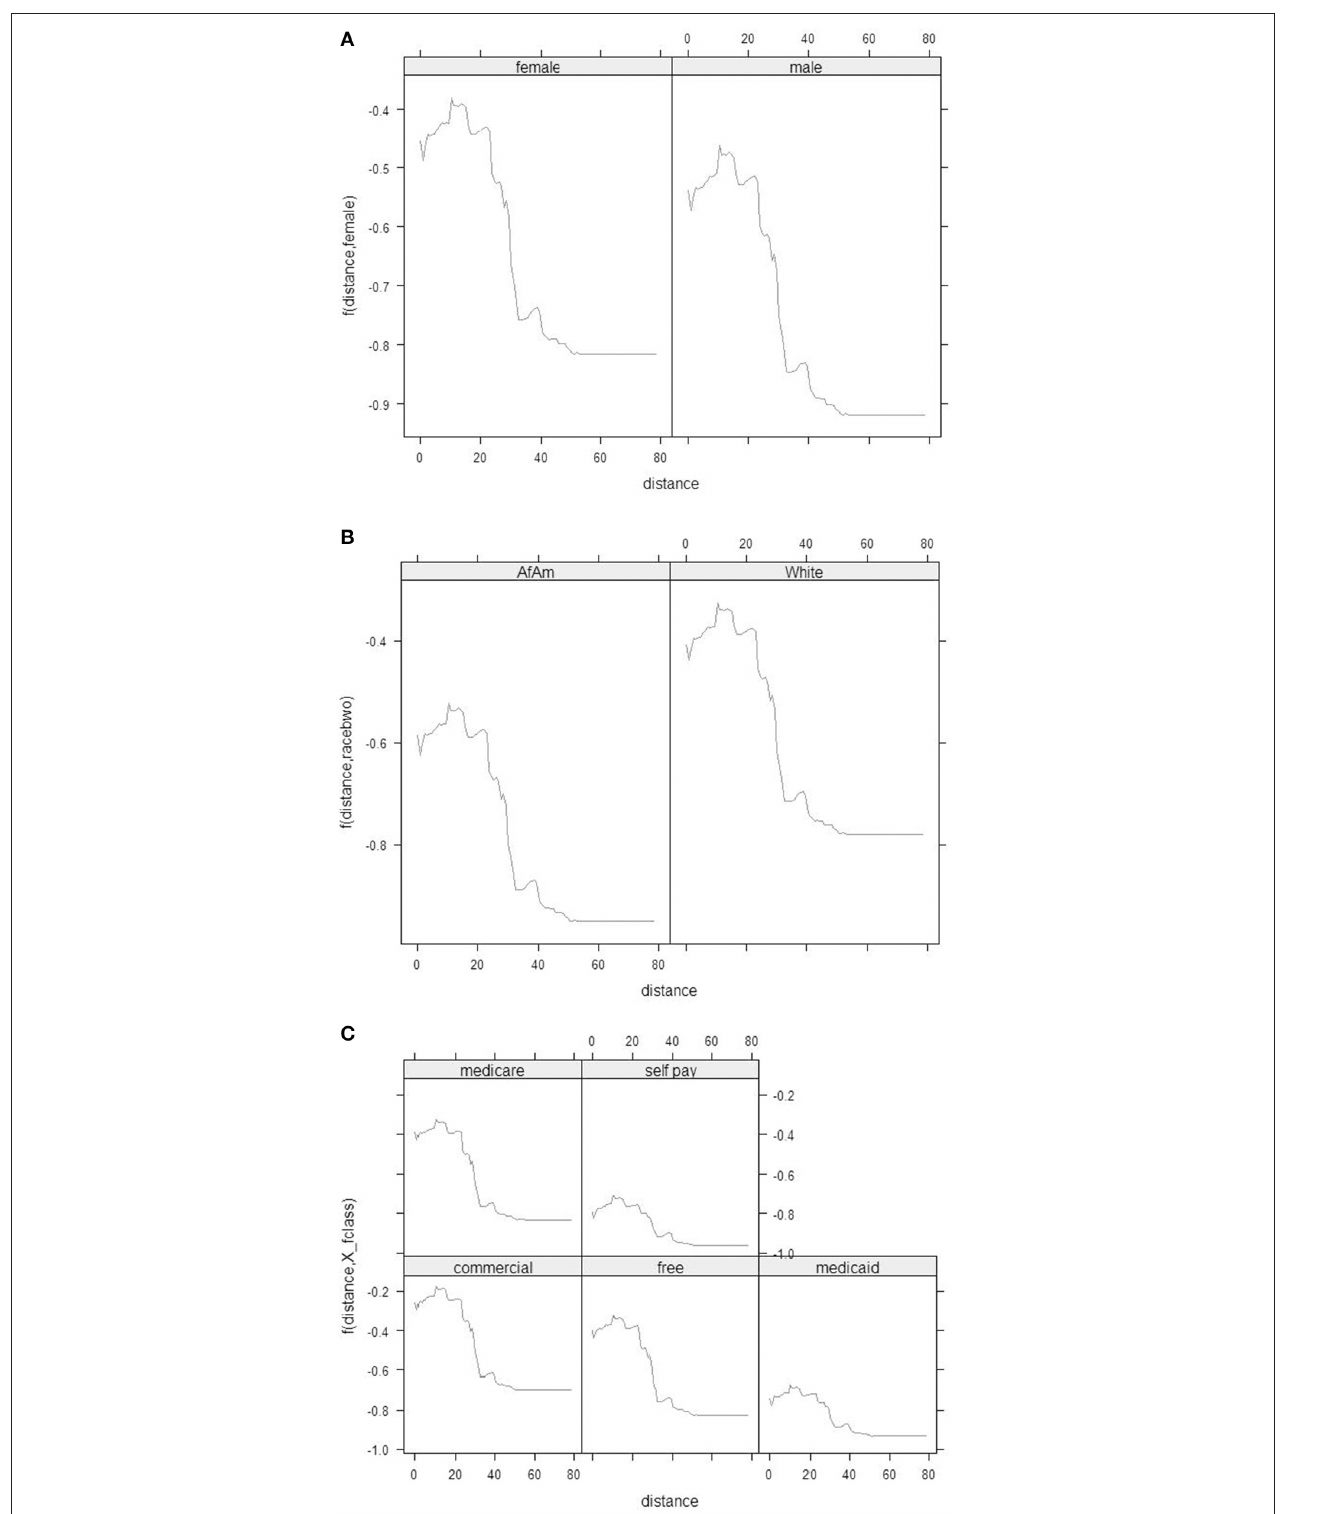
FIGURE 3 | (A) Partial dependence plots between the distance (x-axis) and the log odds of attending the smoking cessation class by females and males separately. (B) Partial dependence plots between the distance (x-axis) and the log odds of attending the smoking cessation class by races. (C) Partial dependence plots between the distance (x-axis) and the log odds of attending the smoking cessation class by Payment Method.